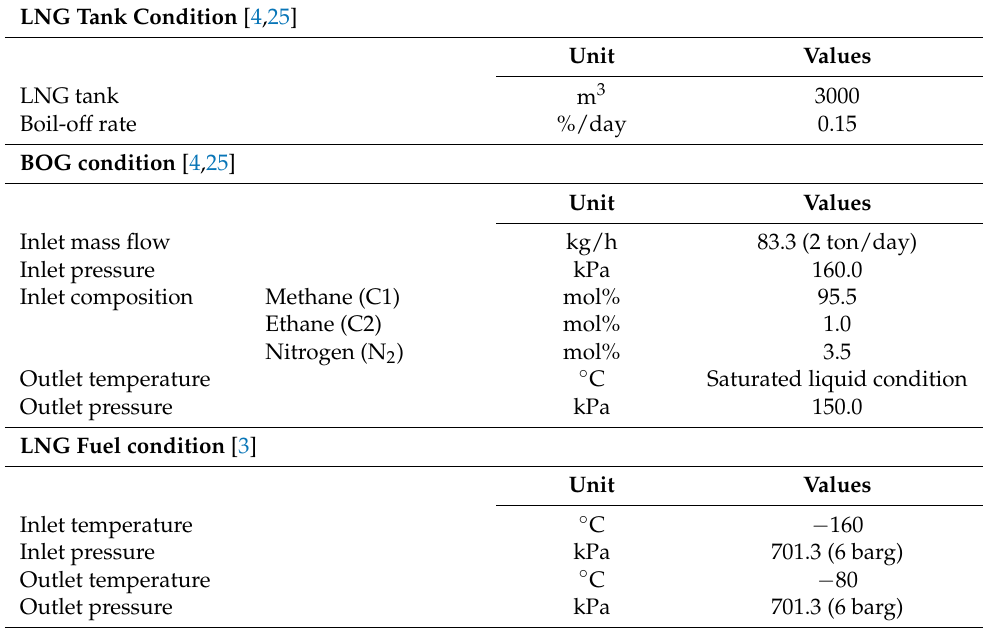
Table 1. LNG tank, BOG, and LNG fuel conditions for the BOG re-liquefaction systems.